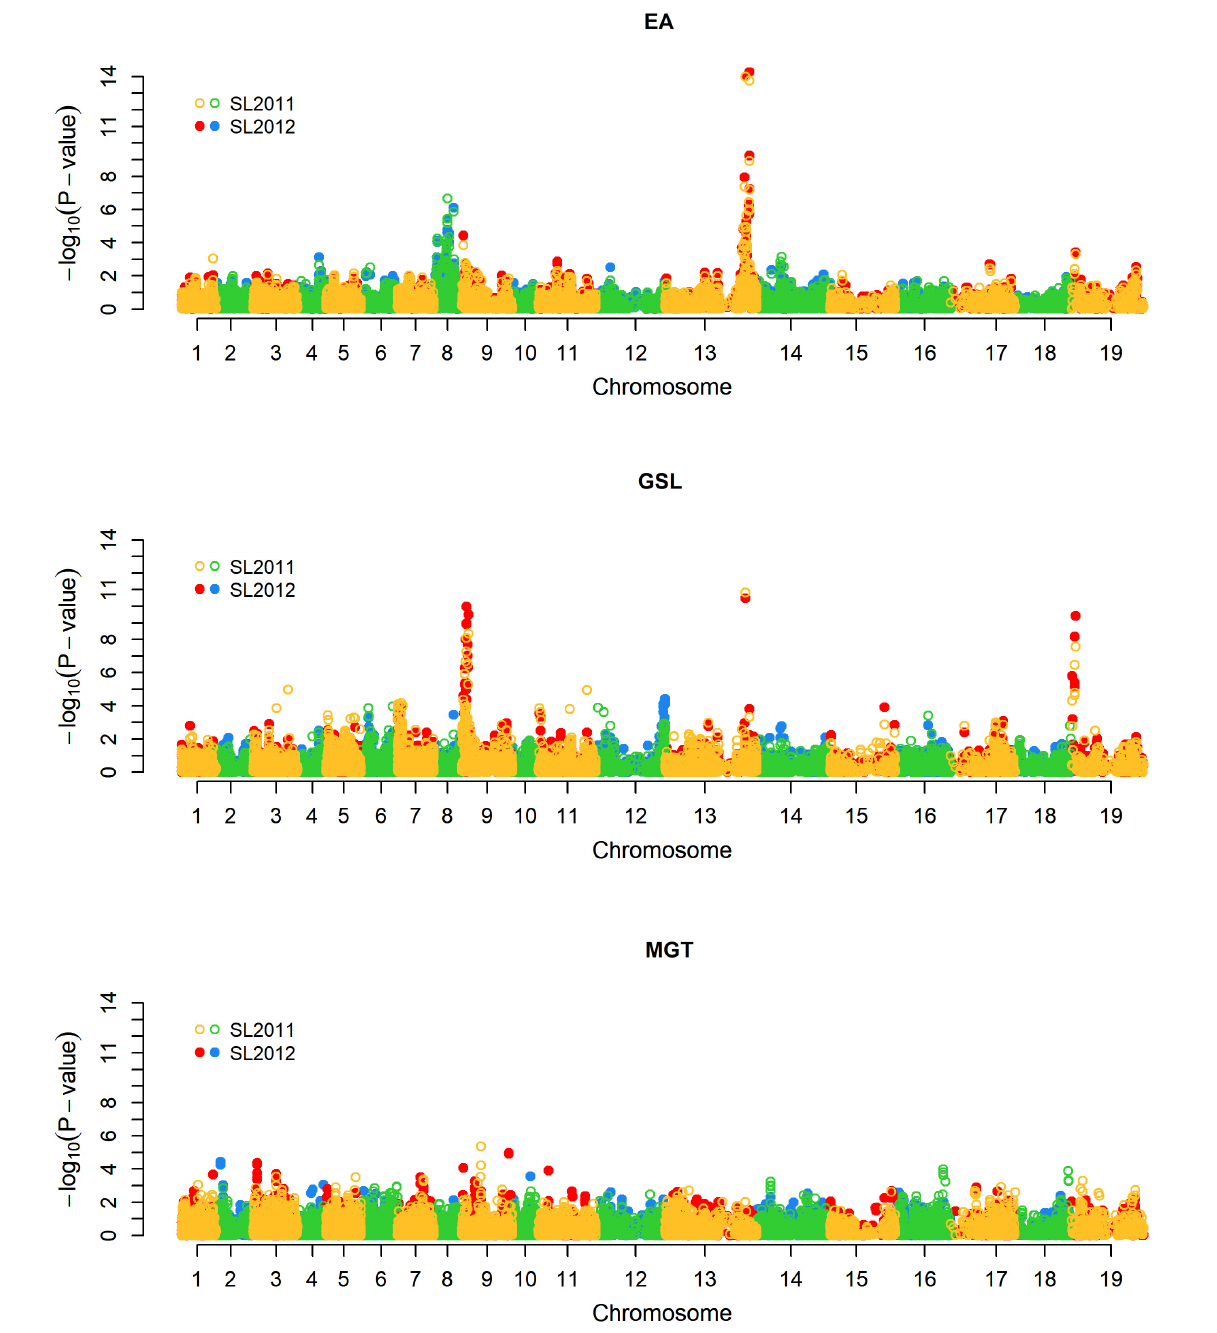
harbored a total of 26 genes ( Supplementary Table S2 ).